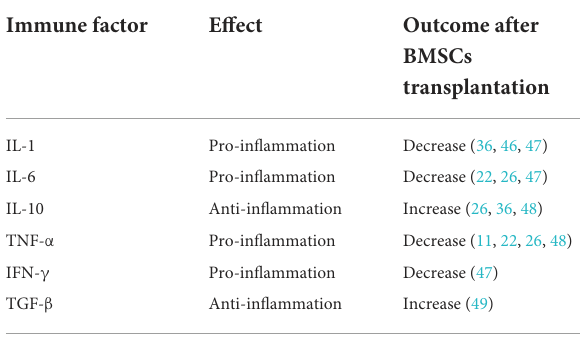
TABLE 1 List of important immune factors and their